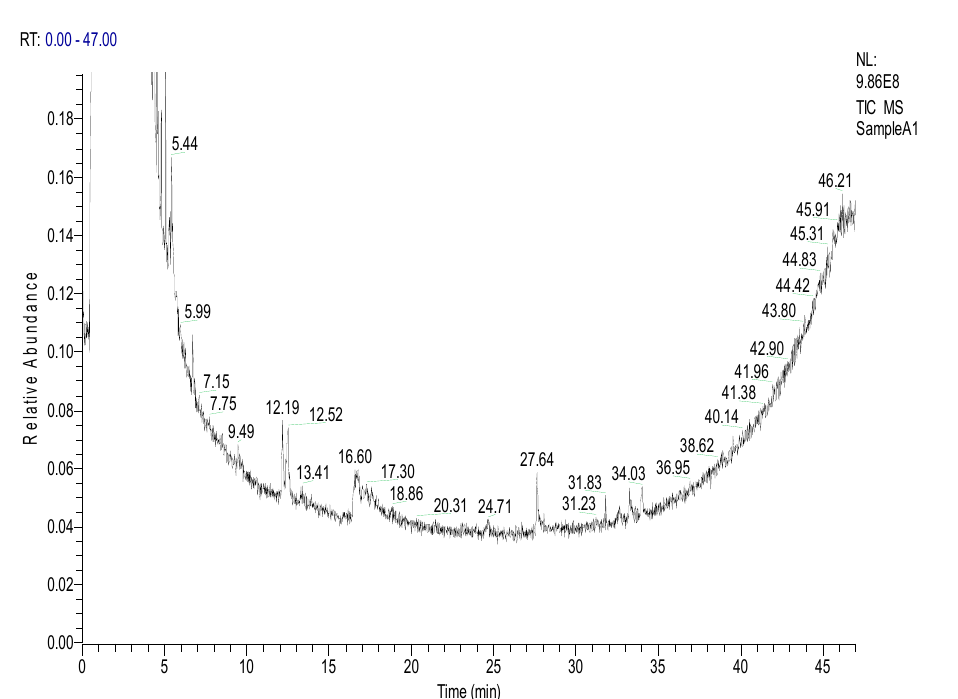
Figure 3. GC-MS chromatogram of the n -butanol fraction of Chrozophora tinctoria (NBFC). The numbers inside the chromatogram are the retention times of the compounds. Table 2. Bioactive compounds identified in the n -butanol fraction of Chrozophora tinctoria through GC-MS.